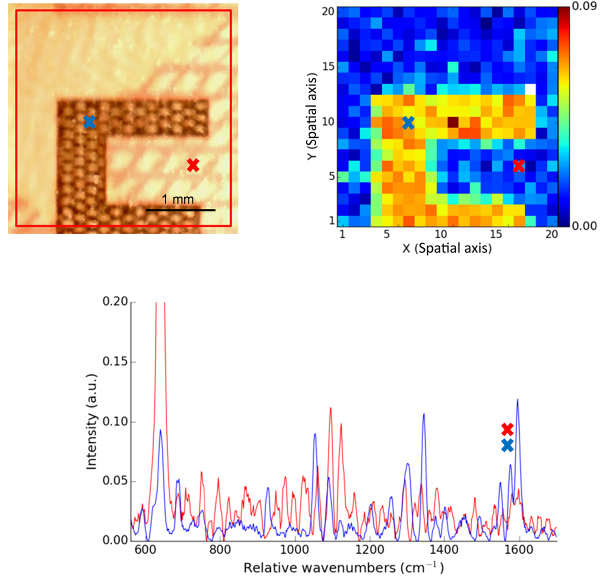
Figure 9. Part of the letter “E” printed on a EUR 10 bill. Upper left: camera picture. Upper right: pseudo color Raman image of the intensity at 1576 cm − 1 , which corresponds to the distribution of Fig. 7: Granules and powder of the pain reliever Aspirin Effect. Upper left: Camera picture. Upper right: Pseudo color Raman the printing ink of the “E”. Below: corresponding SERDS spectra at image of the intensity at 1606 cm -1 , which corresponds to the distribution of the agent acetylsalicylic acid. Below: positions Corresponding SERDS spectra at the positions  and  (1 s recording time per laser).